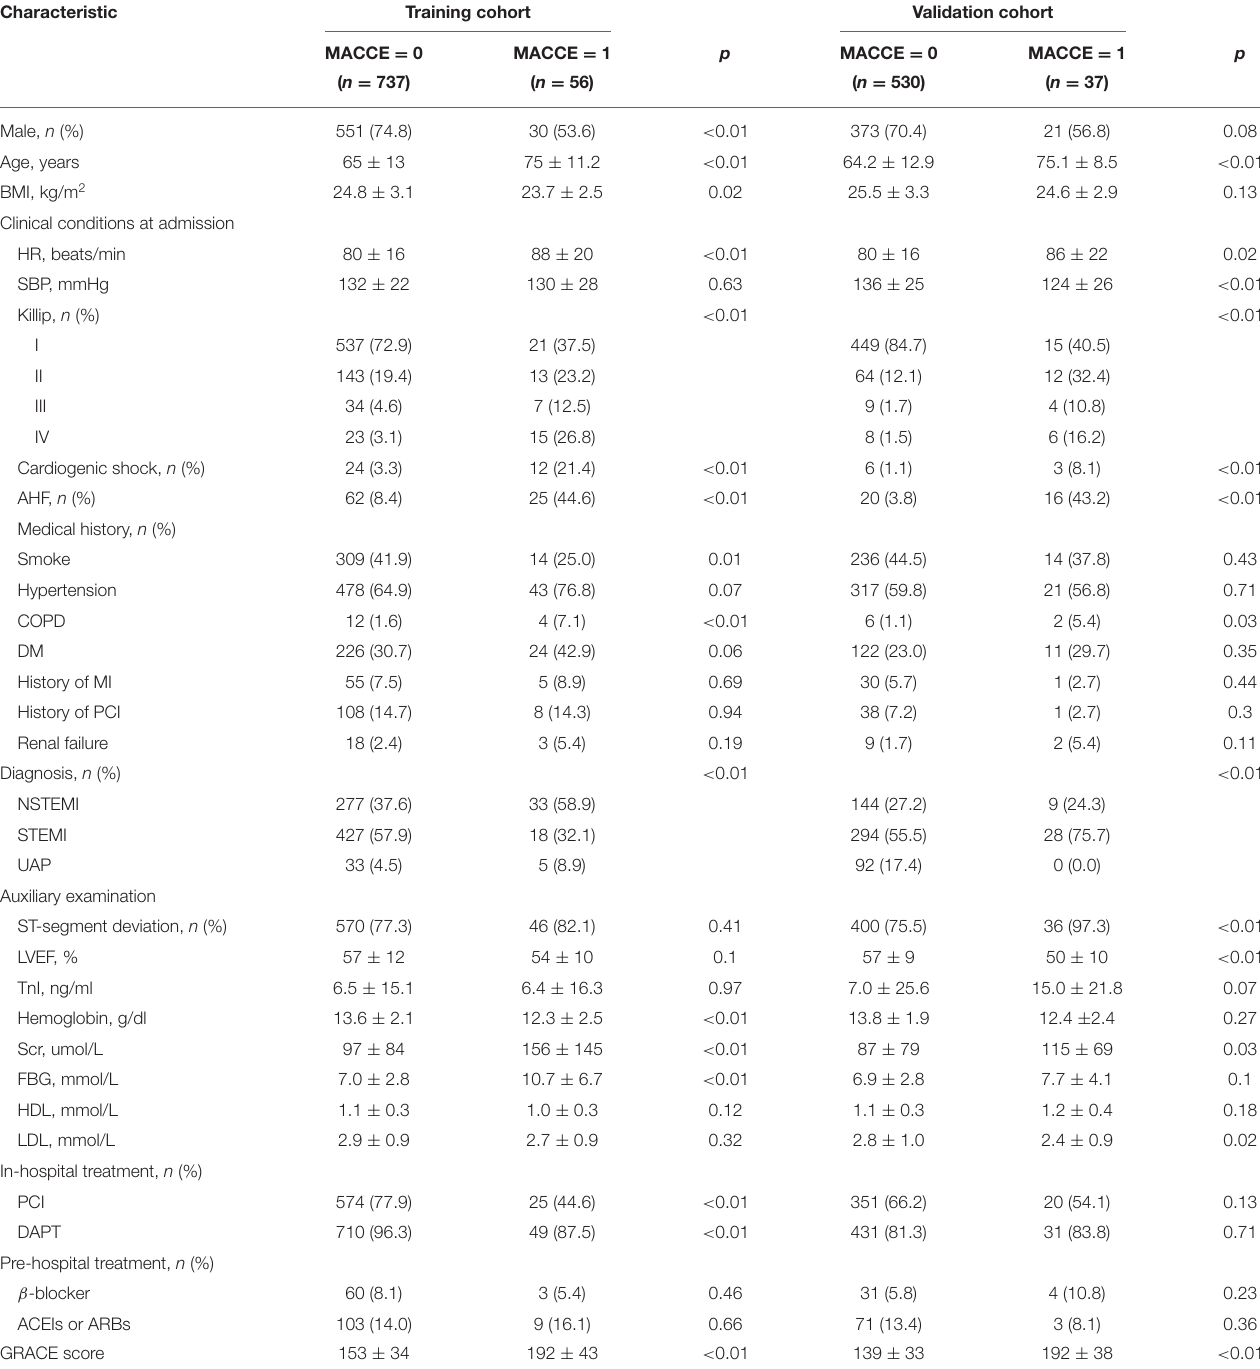
TABLE 1 | Baseline characteristics of ACS patients with or without in-hospital MACCE.